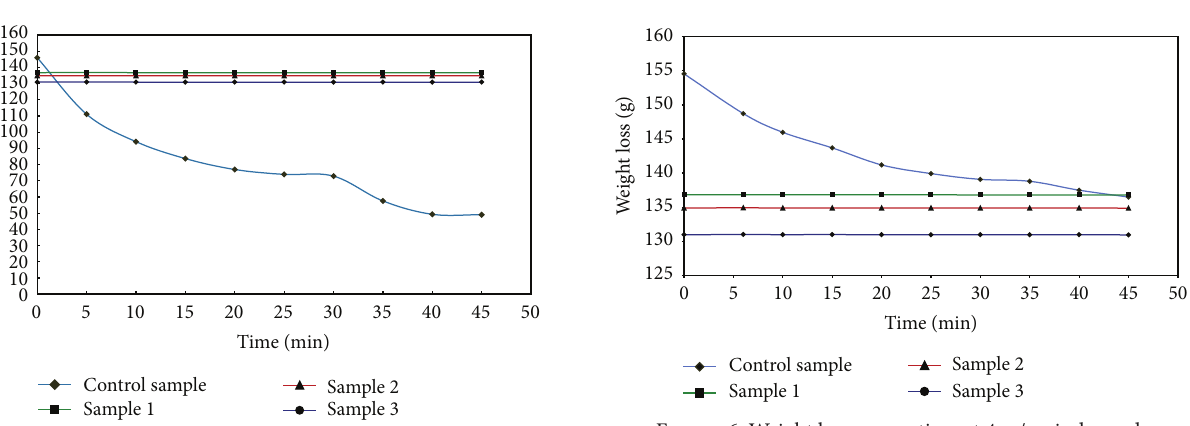
Once again, the treated trays remained unaffected by the reduced wind speed. Figure 7 illustrates the sand weight loss versus time at 10 m ⋅ s −1 wind speed. Only 4 minutes were required to reduce the sand weight by almost 75%. The